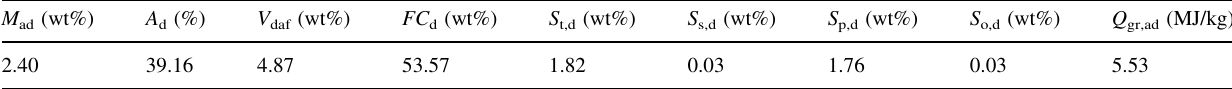
Table 1 Proximate and ultimate analysis of a raw stone coal sample